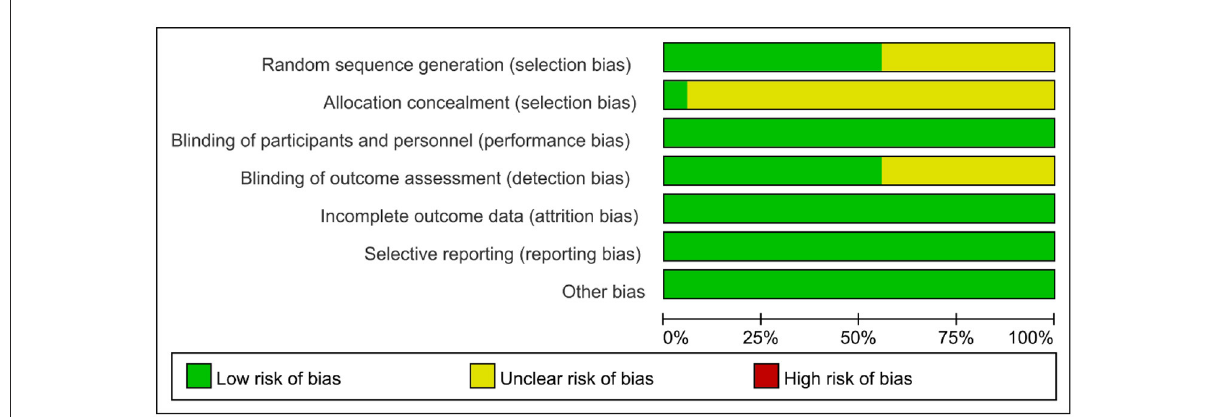
FIGURE2 Risk assessment of bias.